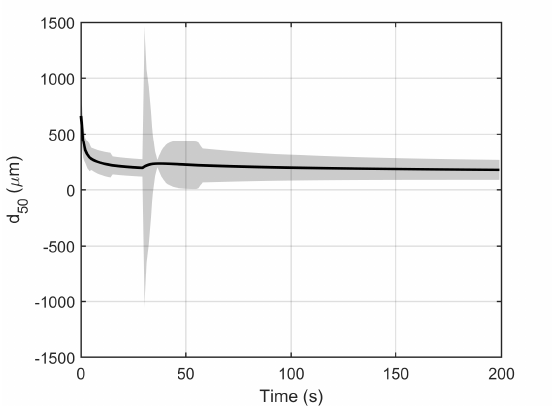
Figure 5. Model prediction (black solid) with 95% confidence range (shaded) using the linearization